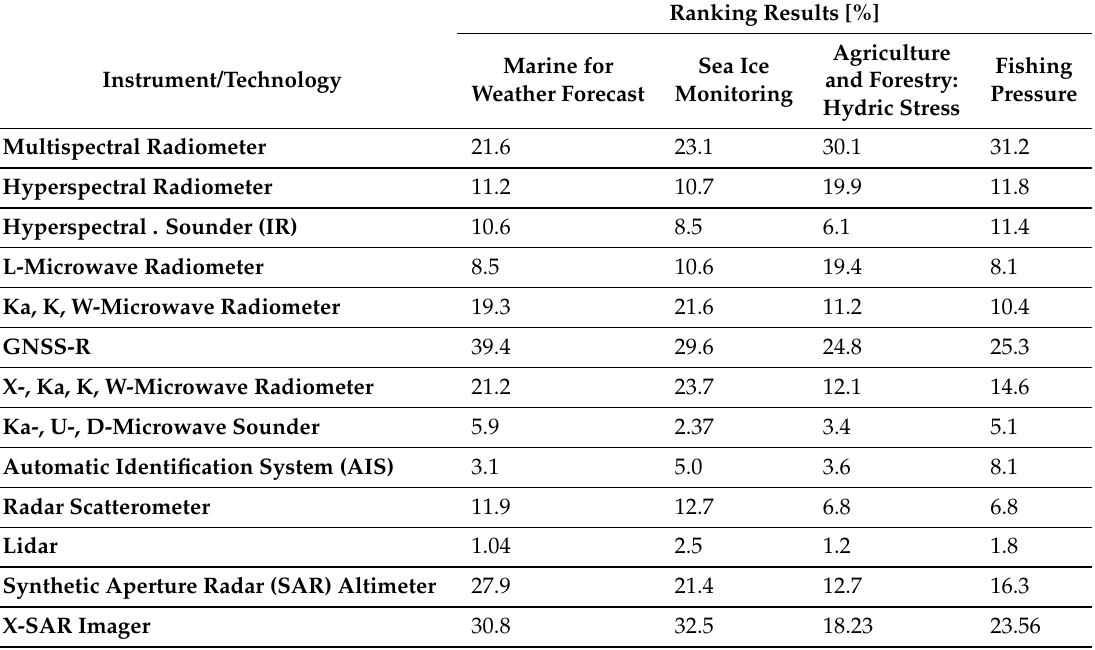
Table 12. Ranking results for each technology for each use